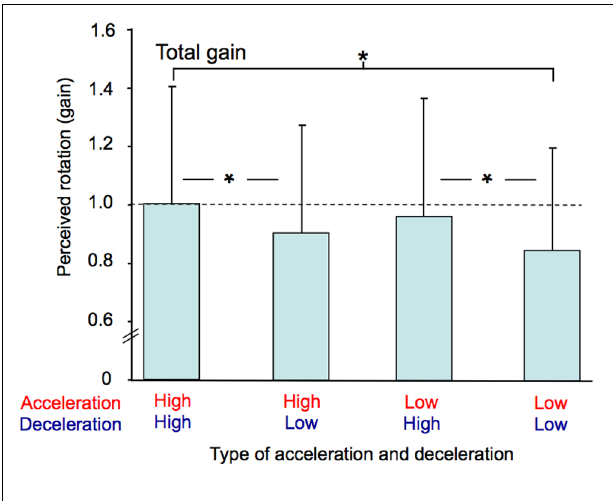
FIGURE 7 | Mean total gain computed for each combination of acceleration and deceleration (averaged for both counter-clockwise and clockwise rotations). The vertical bars represent between-subjects standard deviations and the dotted line indicates a gain of one. * p <